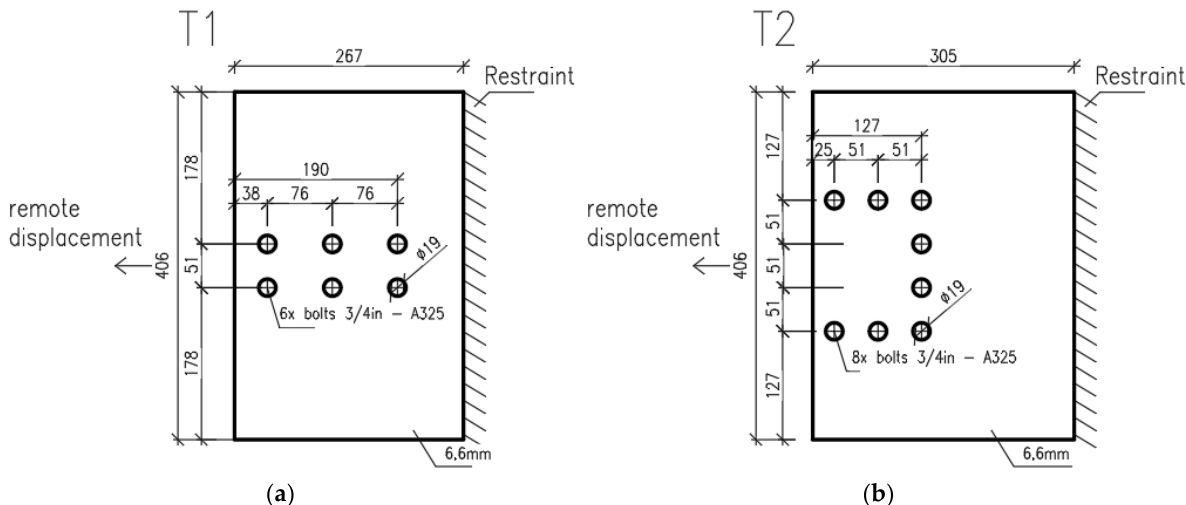
Figure 8. Simplified geometries used for FEM simulations: ( a ) specimen T1 and ( b ) specimen T2 [7], dimensions in mm.